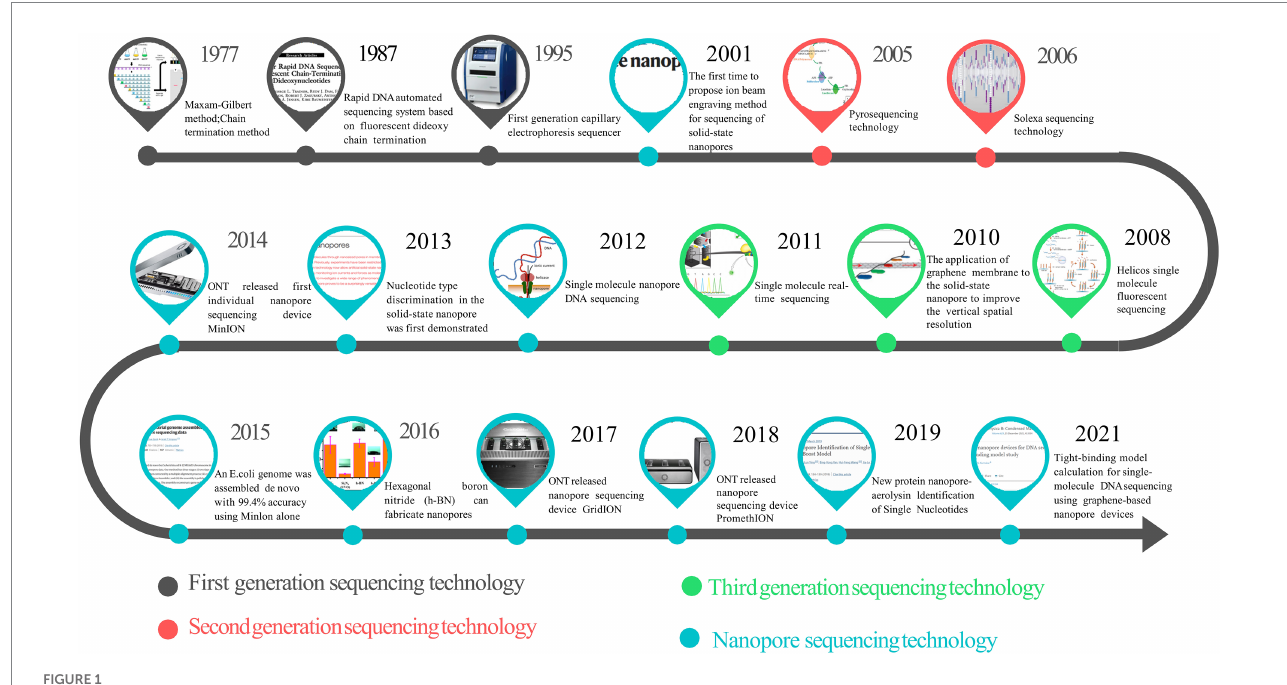
FIGURE 1 The timeline of sequencing technology